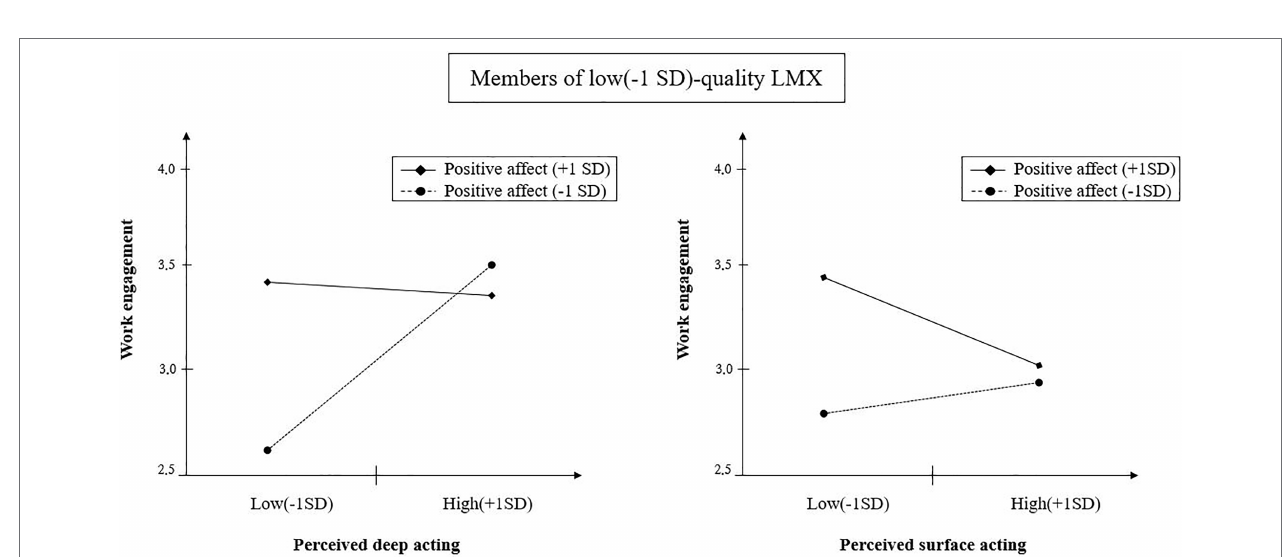
FIGURE 2 | Three-way interaction slopes with work engagement as the dependent variable for members with high-quality LMX.